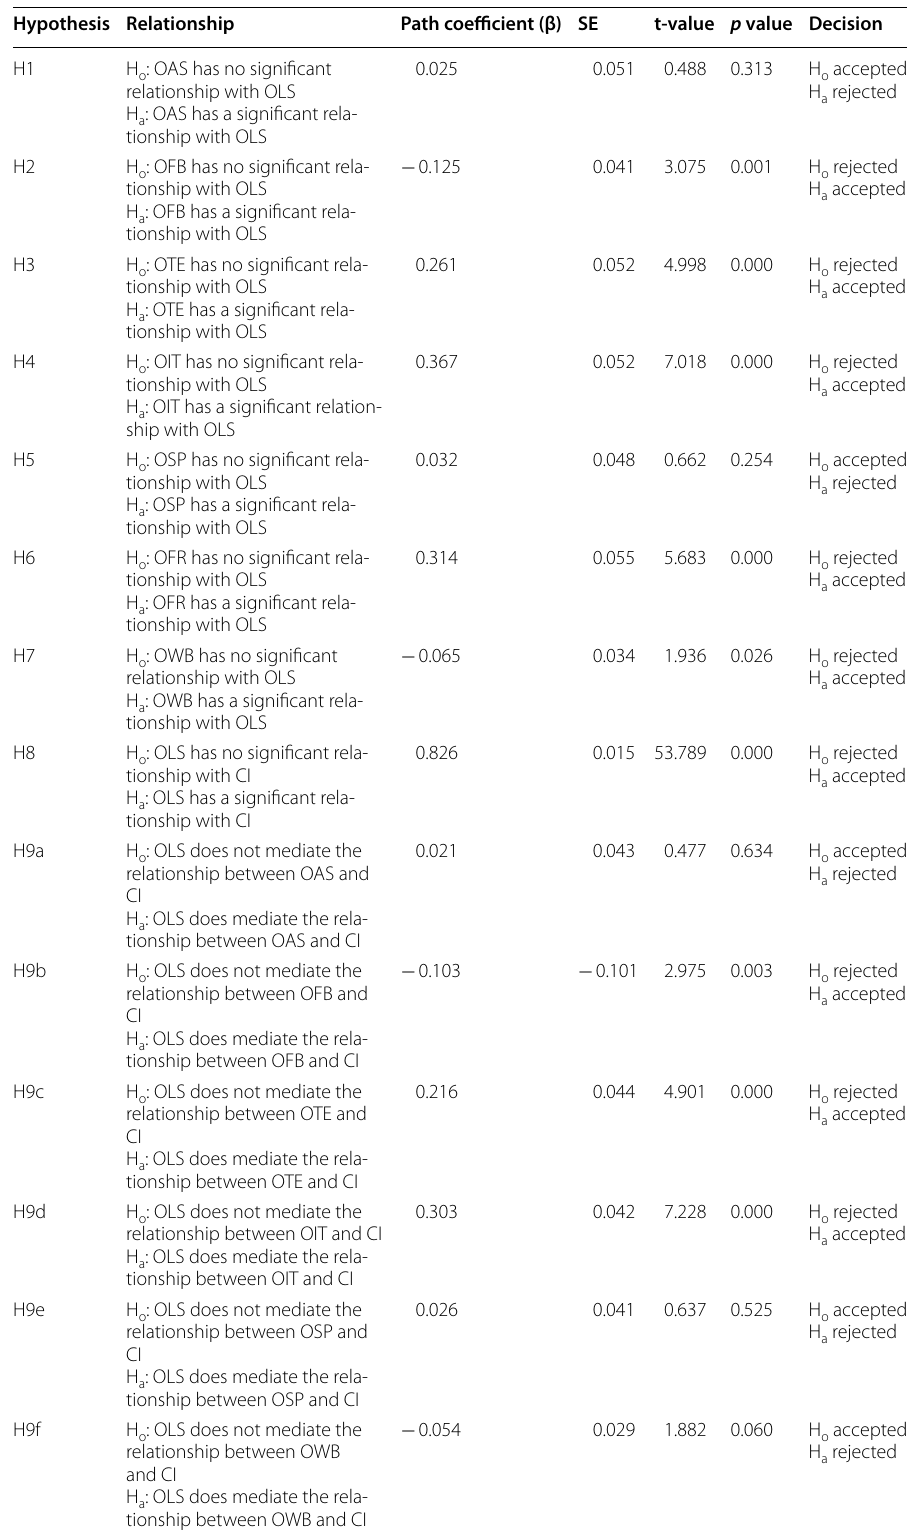
Table 5 Hypothesis testing